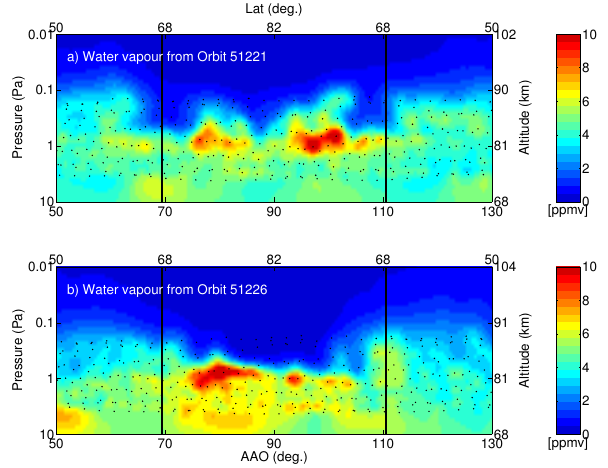
Figure 7. Example results from orbit 51221 and orbit 51226 on 15 July 2010. The lower x -axis shows the AAO and the top axis shows the true latitude of the measurements. The black lines indi- cate the positions of collocated ACE-FTS and AIM-SOFIE mea- surements. The black dots are the tangent position for each mea- surement.